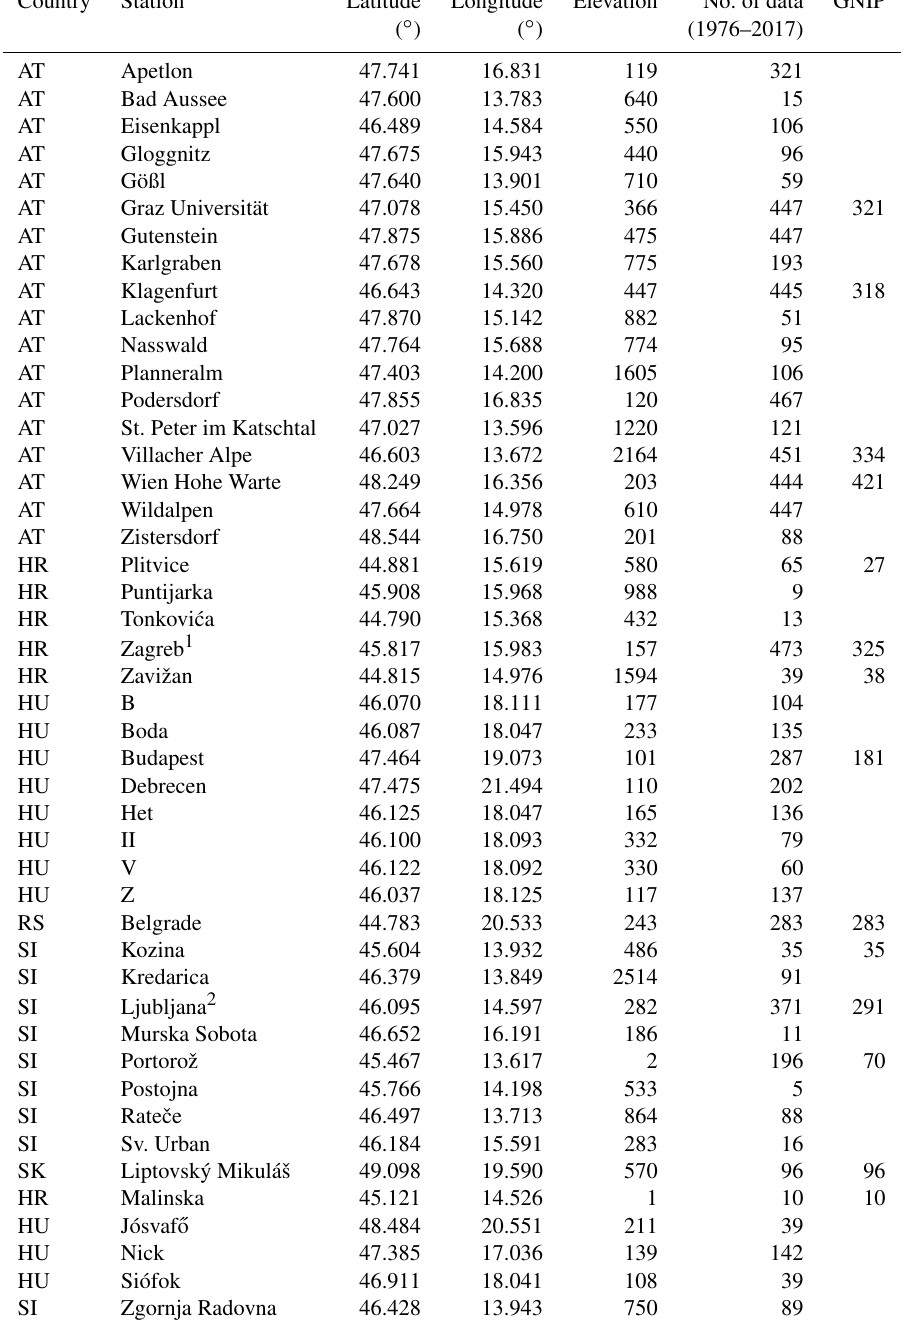
Table 1. Sampling sites with basic geographical information used in the study arranged alphabetically by country code (ISO-3166-1 ALPHA- 2) and station name. The number of monthly precipitation 3 H activity concentration data between 1976 and 2017 used in this study is indicated as well as the number of monthly data available in the Global Network of Isotopes in Precipitation in the same period (column title: GNIP). The stations below the dashed line were used for model performance testing (for details see Sect.